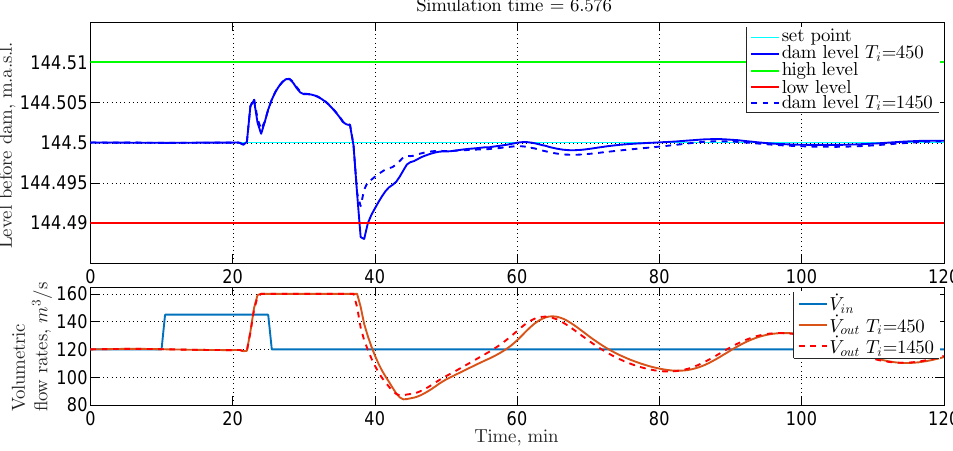
Figure 6: The results of simulation with PI controller ( T s = 30 , K p = − 2850 and T i = 450 and 1450).